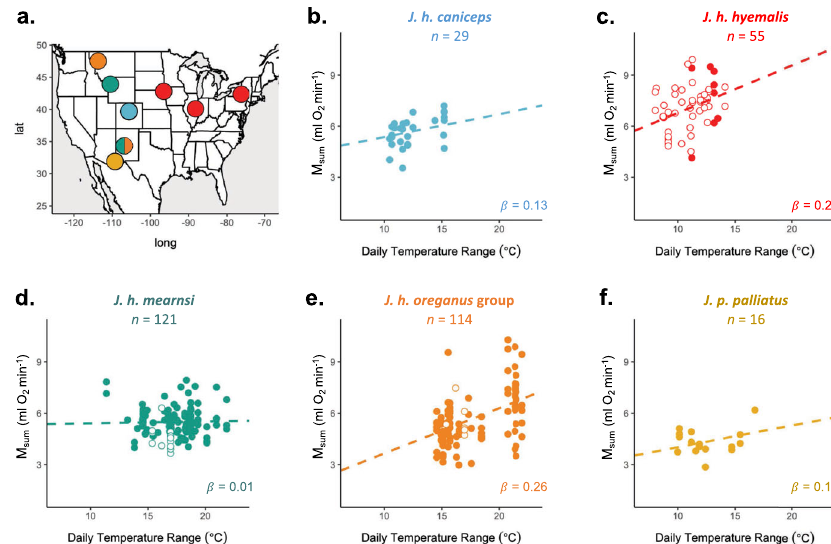
Fig. 1 Relationships between daily temperature range and thermogenic capacity (M sum ) differ among fi ve Junco taxa assayed in the fi eld. a Map of sampling sites for fi eld measurements color-coded by taxon, following color scheme in b – f and plotted in R with package mapdata 87 . b – f Taxon-speci fi c relationships between M sum and daily temperature range (averaged over the 8 days prior to capture), while controlling for differences in body mass. Each dot represents an individual ( n = 335). Sample sizes for each taxon are listed at the top and the slope ( β ; in ml O 2 min − 1 °C − 1 ) of each relationship is shown in the lower right corner. Sampling occurred during the breeding season ( fi lled circle) or nonbreeding season (open circle). Lines fi t from glm (M sum = M b + Taxa × T d_range ) using mean M b for each taxon. Source data are provided in the Source Data fi